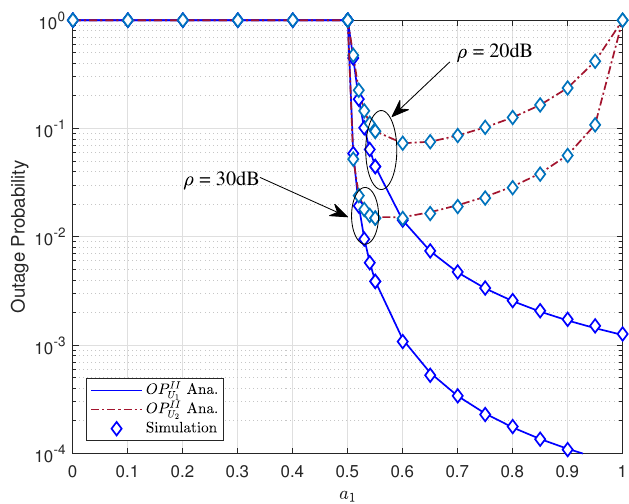
Figure 6. Outage performance of U 1 and U 2 versus a 1 .